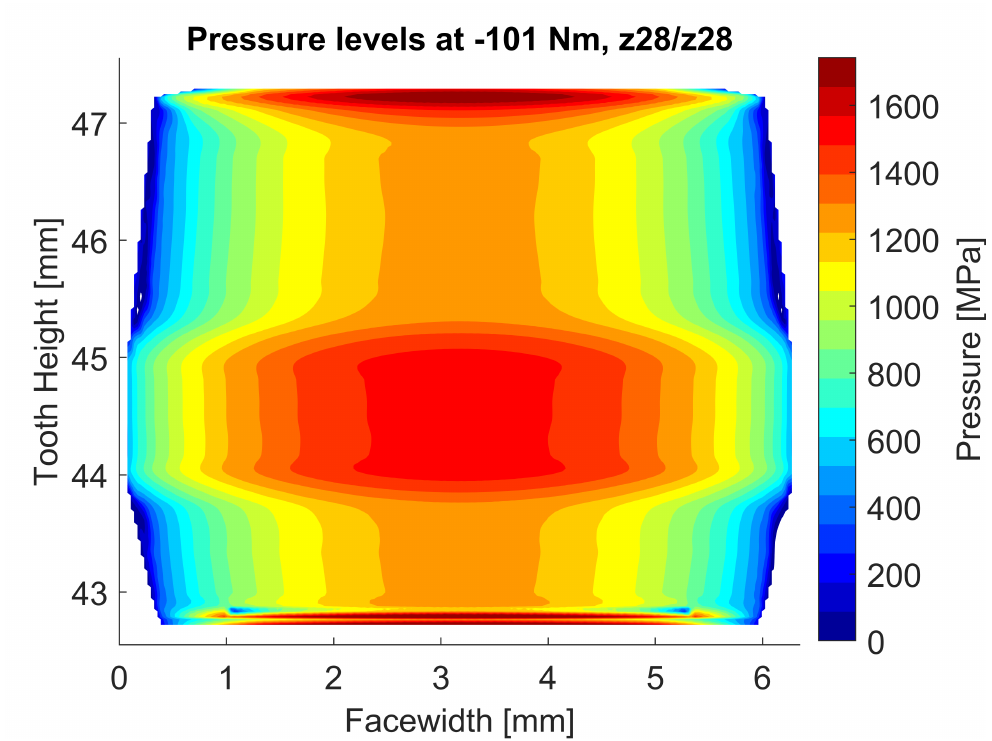
Figure 23. Flank pressure distribution of the tested gear pair with parabolic tip relief, dCa = 94.245 mm and Ca = 32 µ m and C β = C β In = C β Fin = 2 µ m, zL = b /2 and zLc = 0.8 b parabolic